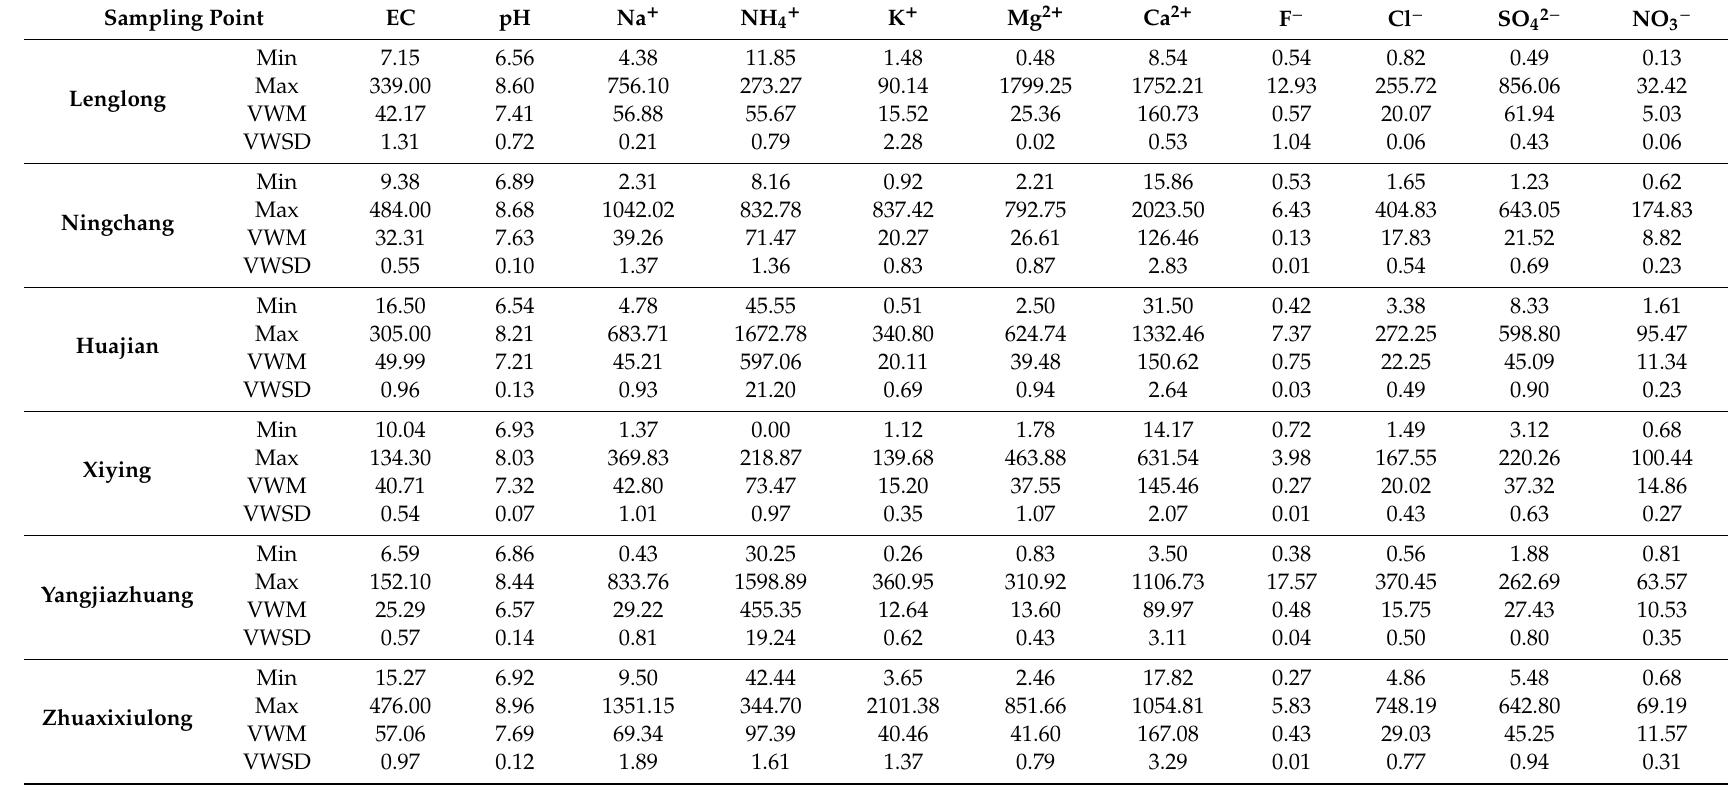
Table 2. Chemical characteristics and main ion concentration of the precipitation